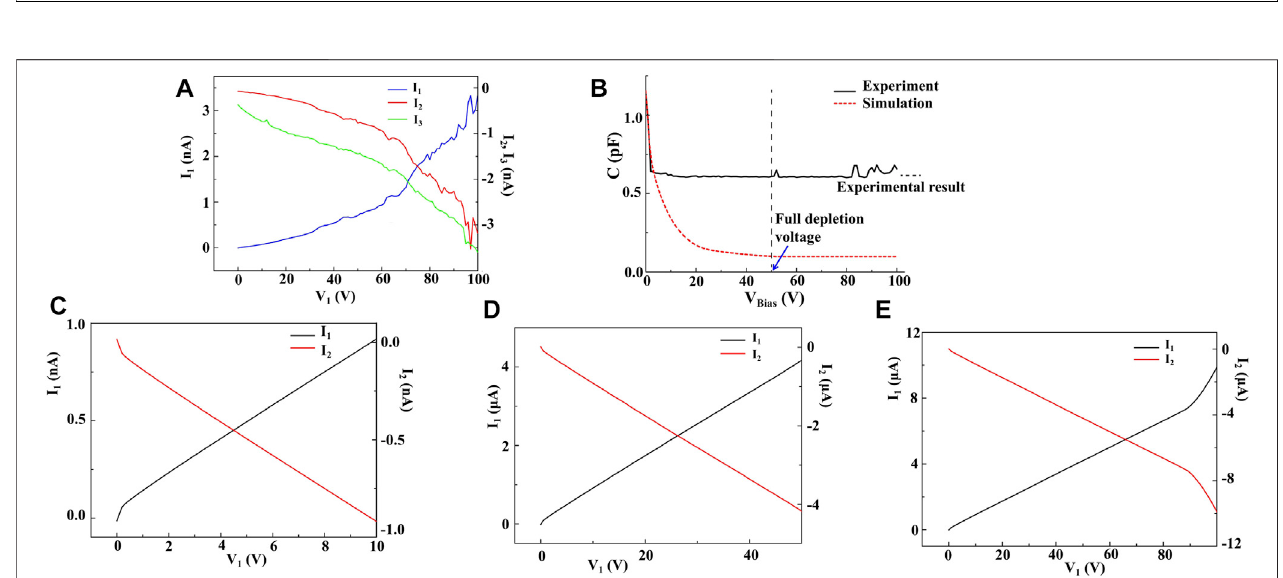
FIGURE 6 | Test results of the 314 mm 2 DSSH-SDD. (A) Leakage current and bias voltage (I – V) characteristics; (B) capacitance and bias voltage (C – V) characteristics; and (C) , (D) , and (E) the spiral resistor current under positive and negative biases at room temperature with bias voltages of 10 V, 50 V, and 100 V.